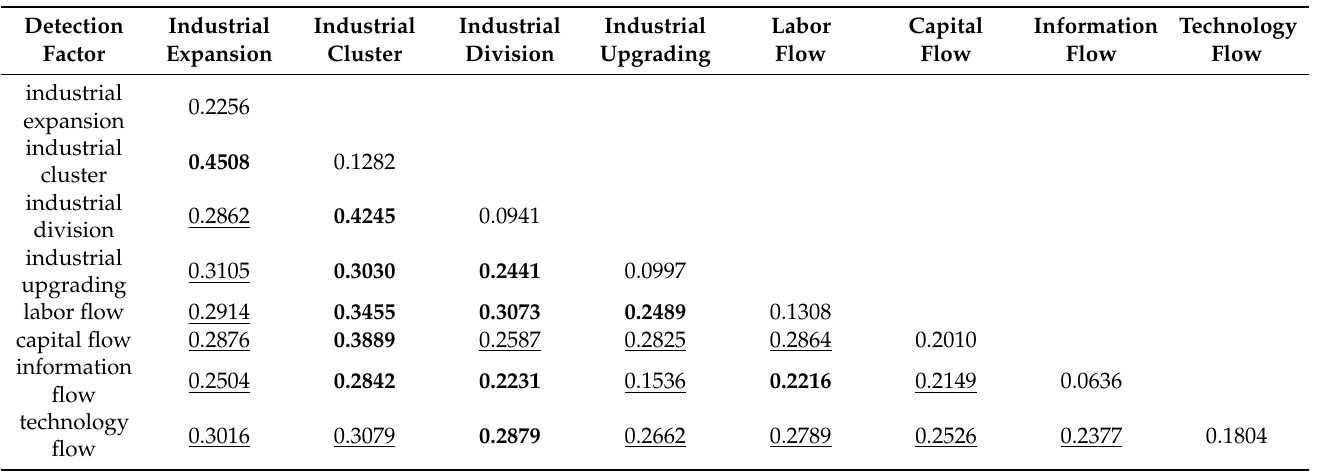
Table 5. Factor detection and interactive detection results of industrial integration for ULUE.